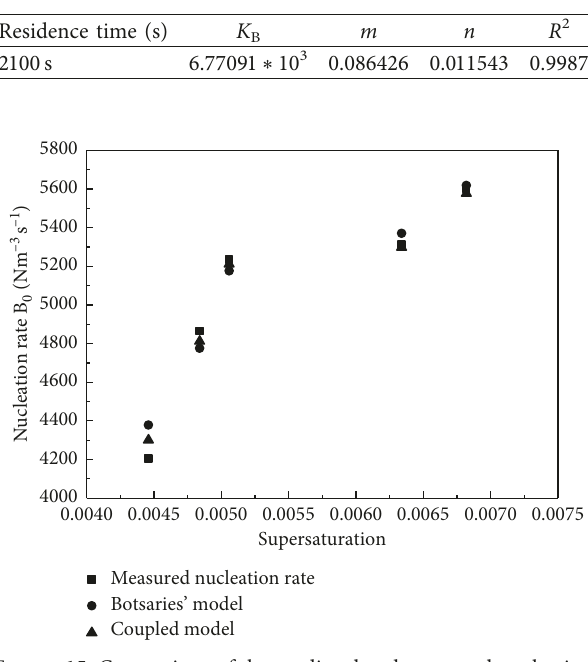
Table 4: The parameters of the nucleation rate for the coupled mode.